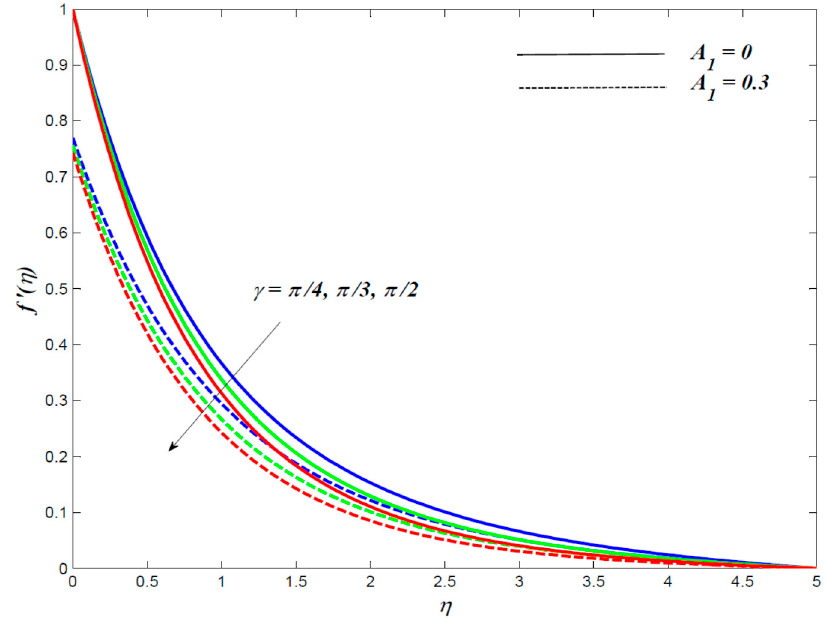
Mathematics 2020 , 8 , x FOR PEER REVIEW Figure 4. Velocity profiles owing to varying values of γ . Figure 4. Velocity profiles owing to varying values of